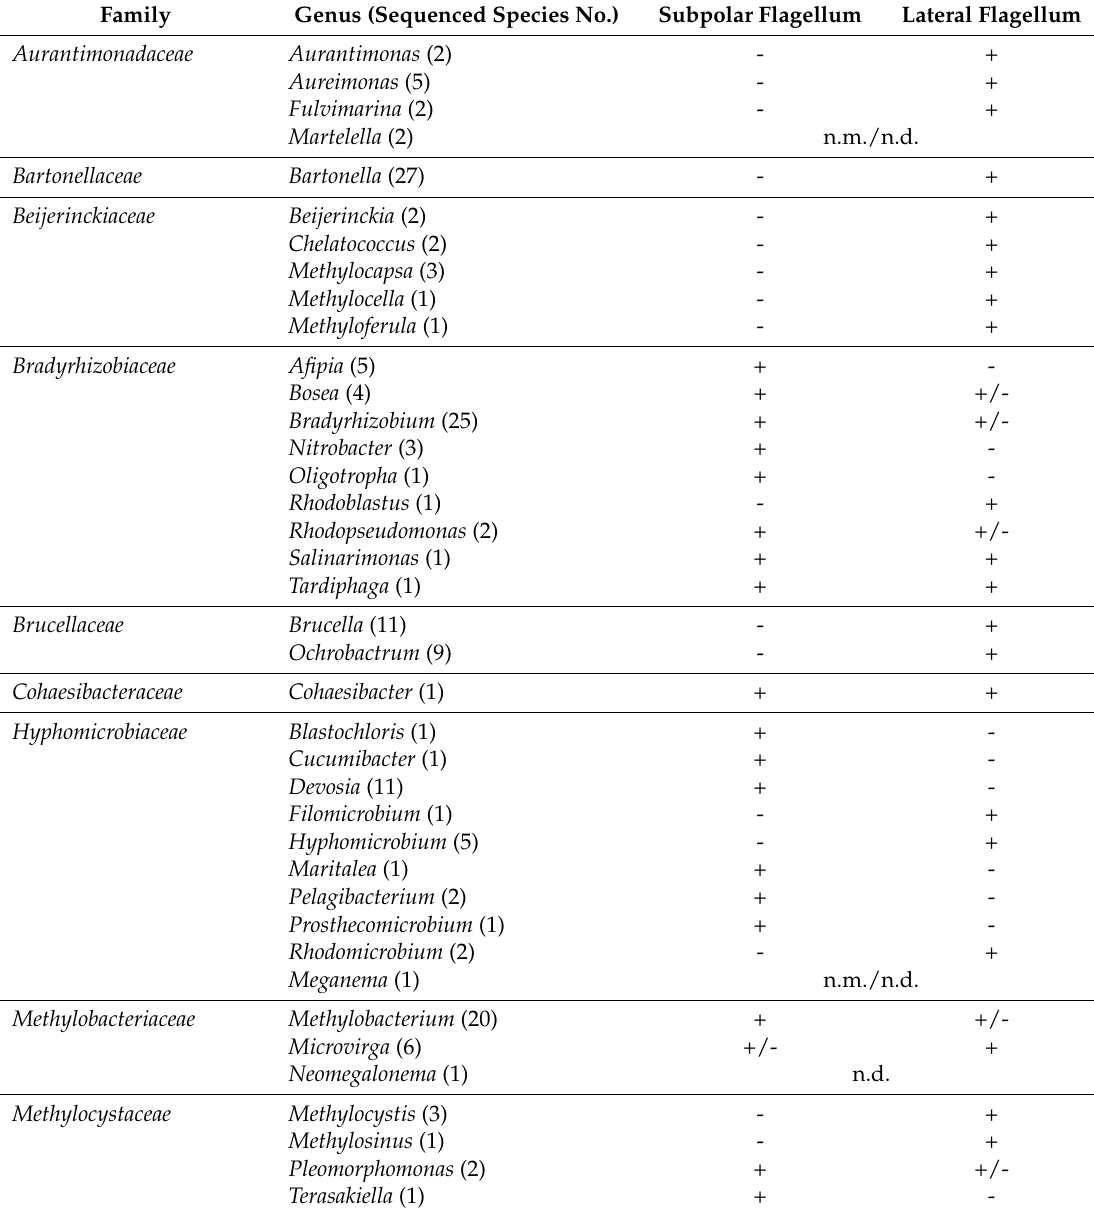
Table 1. Distribution of the flagellar systems in 67 genera of the Rhizobiales order. Family Genus (Sequenced Species